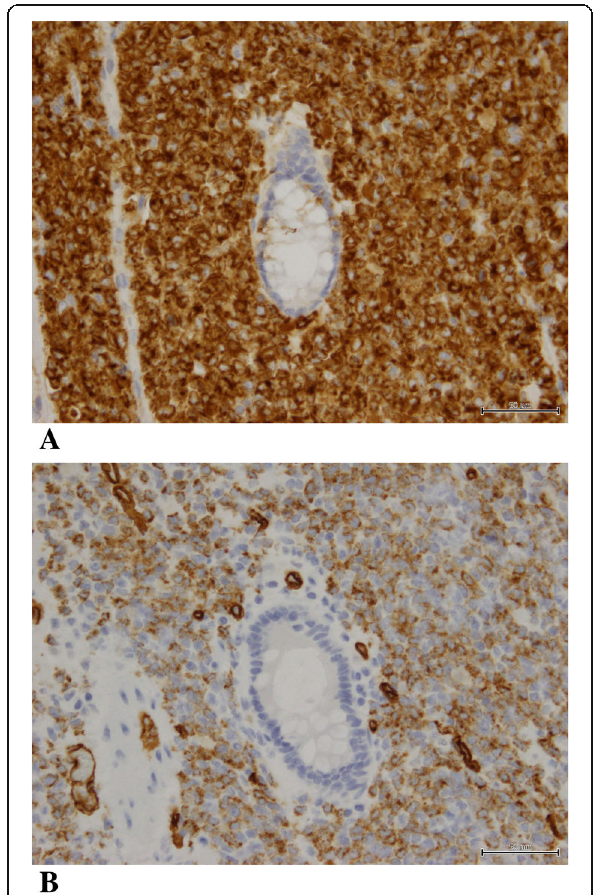
Fig. 5 Immunohistochemistry shows staining of the tumor cells for myeloperoxidase (MPO) ( a ) and CD34 ( b